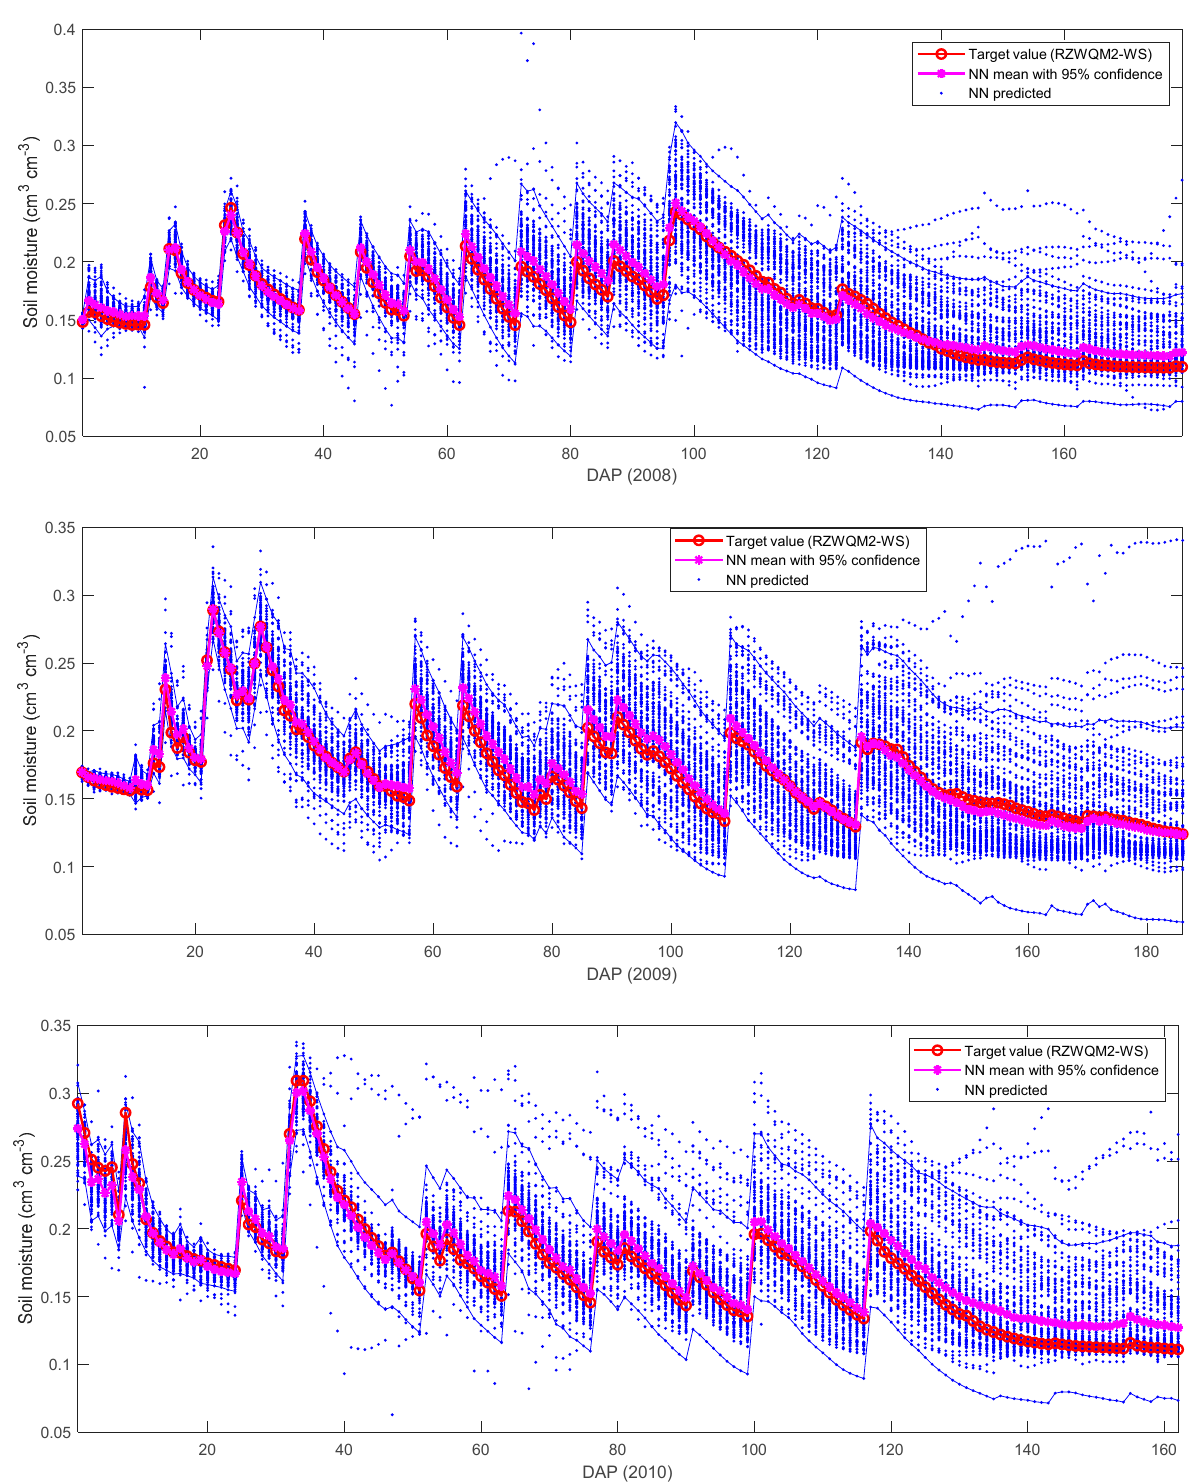
Figure 5. Predicted soil moistures across the root zone of 100 neural network (NN) models with random initial model parameters and given initial soil moisture values, and their daily averages against the target values. The valid line shows the outline of the daily results with 95% confidence, and the daily average soil moisture was calculated using those results within 95% confidence. Each NN model predicted daily soil moisture based on the hesternal value from its own. DAP is day after plant; RZWQM2-WS represents the water stress (WS) method with RZWQM2 simulations.